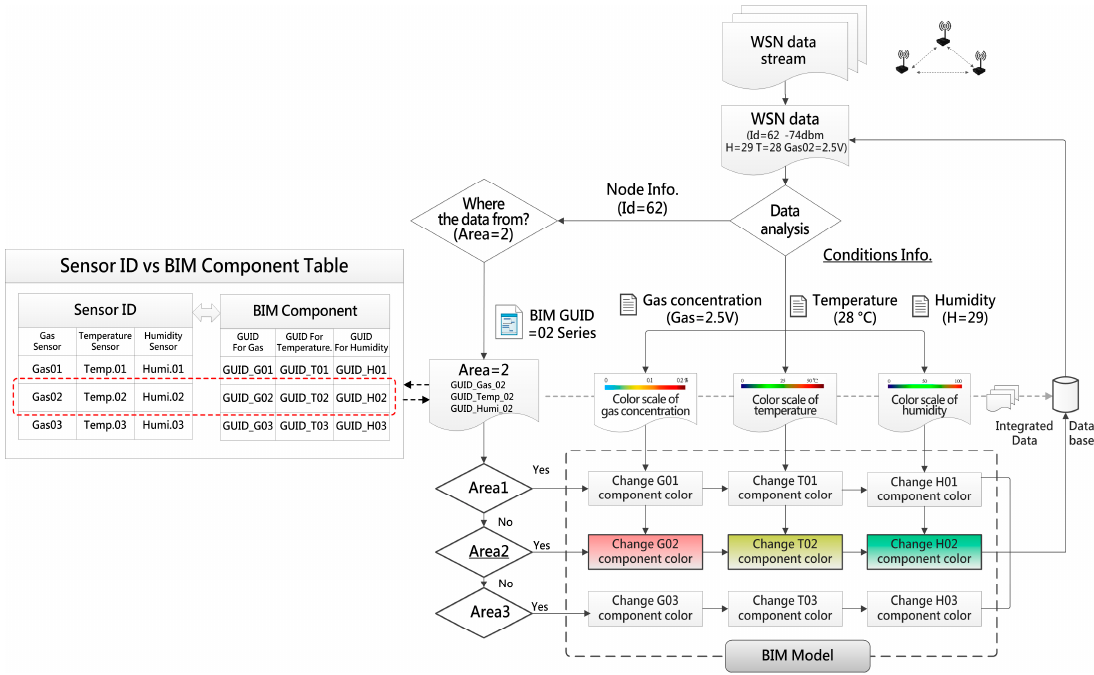
Figure 11. The integrating of WSN data and BIM component.